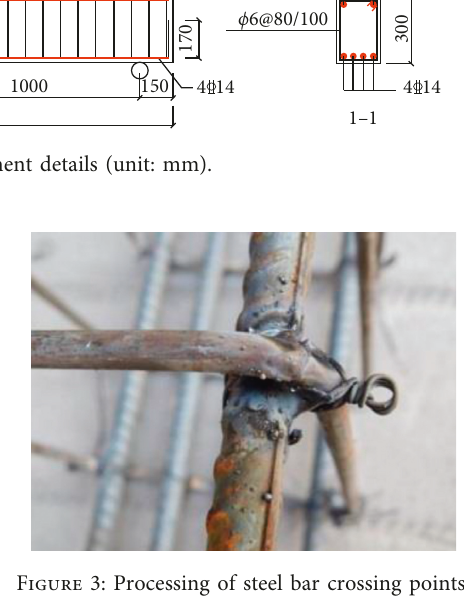
Figure 3: Processing of steel bar crossing